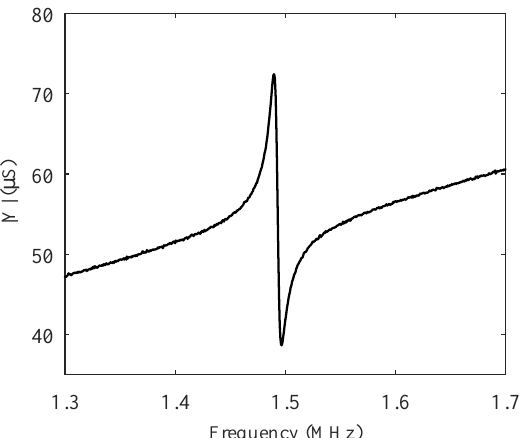
Figure 6. Measurement of the admittance of a PMUT as a function of